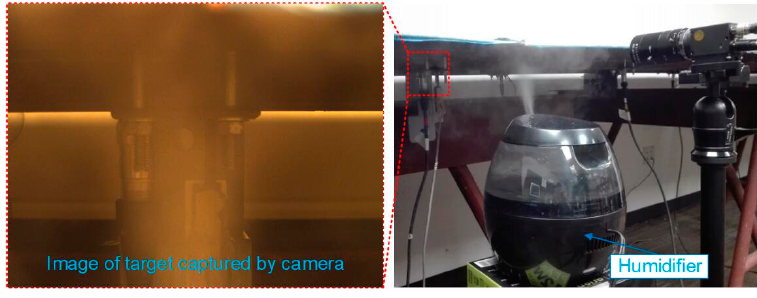
Figure 7. Fog simulation.